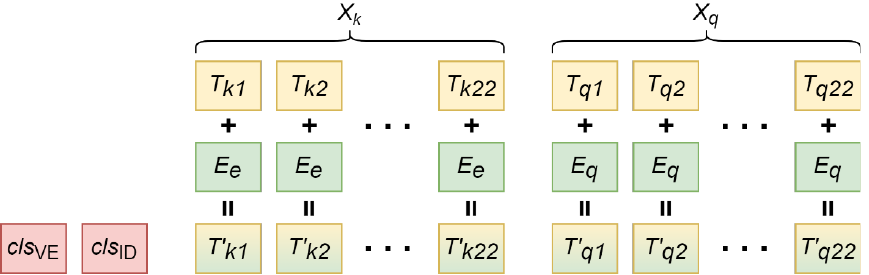
Figure 3. A composite sequence consists of 2 classification tokens, an enrolled sequence, and the query sequence. E e is added to each element in X k = ( T k 1 , T k 2 , . . . , T k 22 ) resulting in ( T (cid:48) k 1 , T (cid:48) k 2 , . . . , T (cid:48) k 22 ) . E q is added to each element in X q =